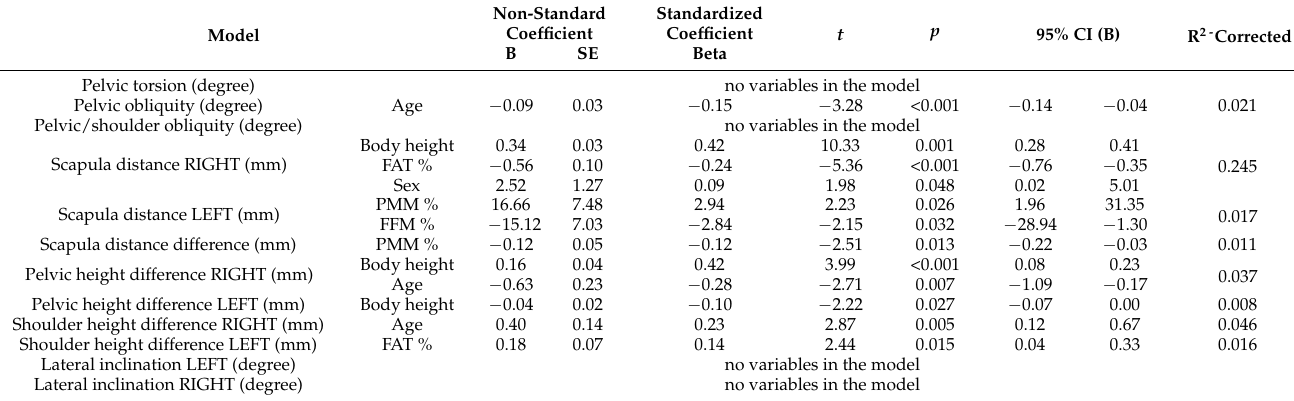
Table 3. Regression of factors influencing body posture parameters in